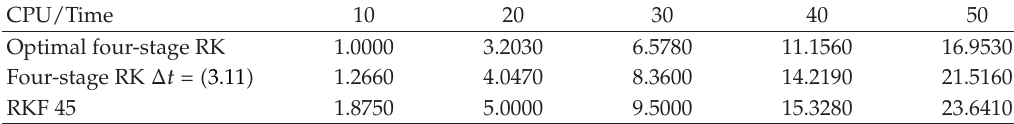
Table 7: Comparison of CPU time between the optimal four-stage RK with the average time step of the “best” and the “worst” cases, and the RKF